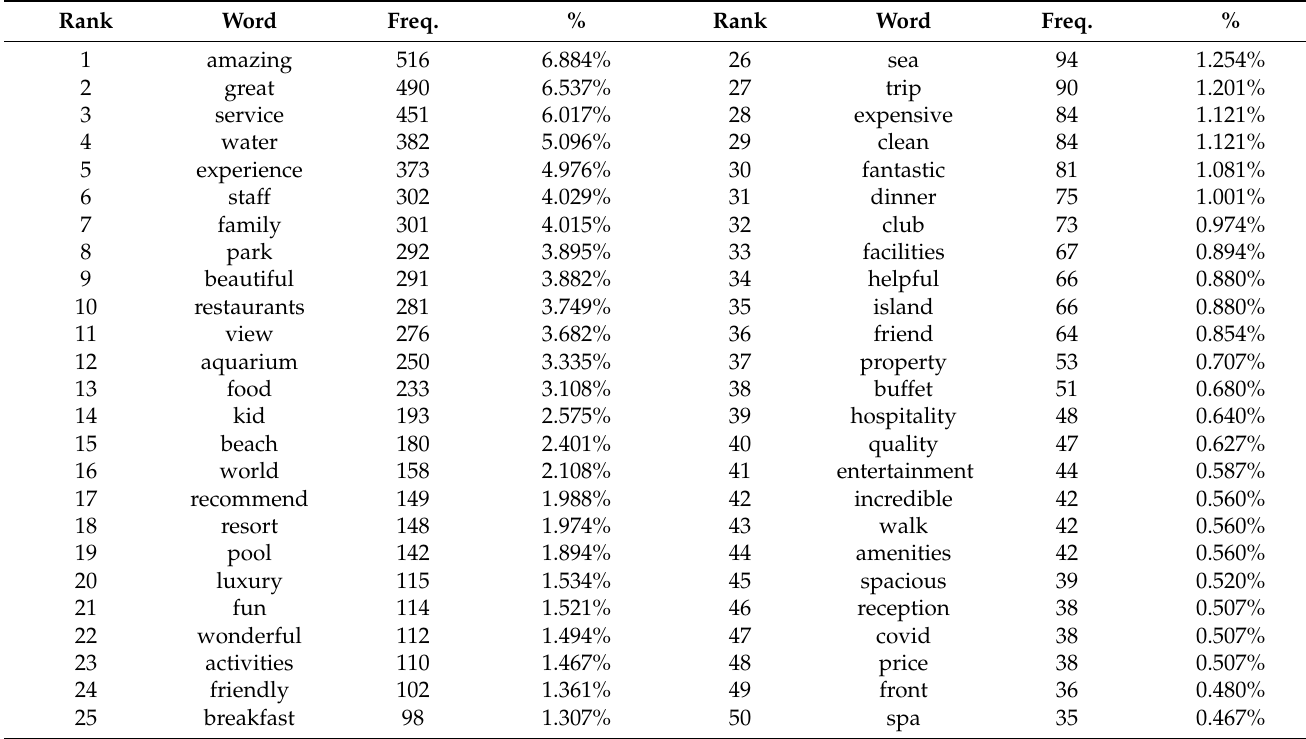
Table 1. Top 50 keywords of customer reviews of Atlantis, The